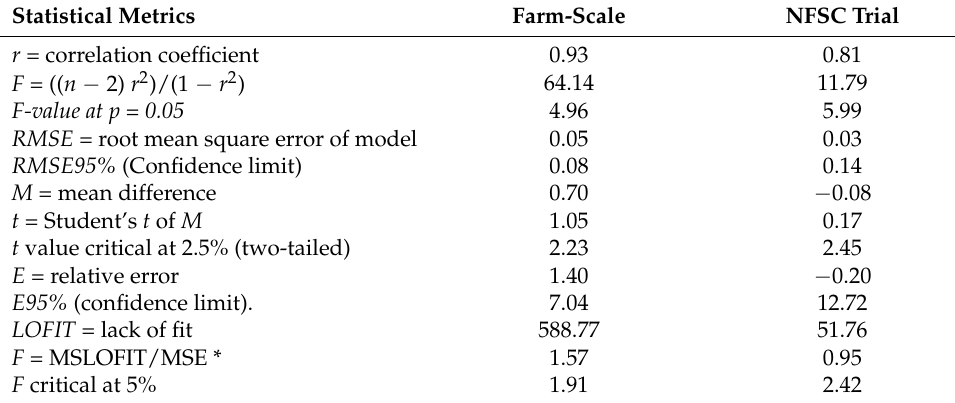
Table 3. Statistical metrics, including correlation coefficient ( r ), root mean square error ( RMSE ), mean difference ( M ), relative error ( E ) and lack of fit ( LOFIT ), applied for the validation between measured and DayCent model-simulated soil C stocks (0–0.20 m) for the farm-scale study and the Nafferton Factorial Systems Comparison (NFSC) trial.